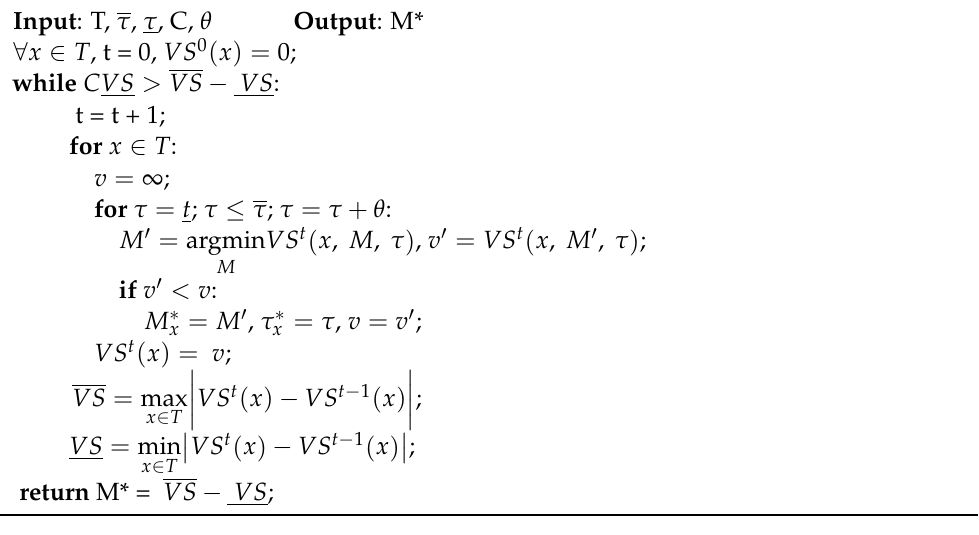
Algorithm 1. Value iteration-based batch sampling in LPC-MTD.